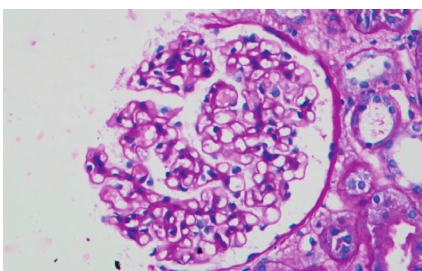
Figure 1: Kidney biopsy specimen on light microscopy showing normal appearing glomerulus without any proliferation or capillary wall thickening (PAS 40x).